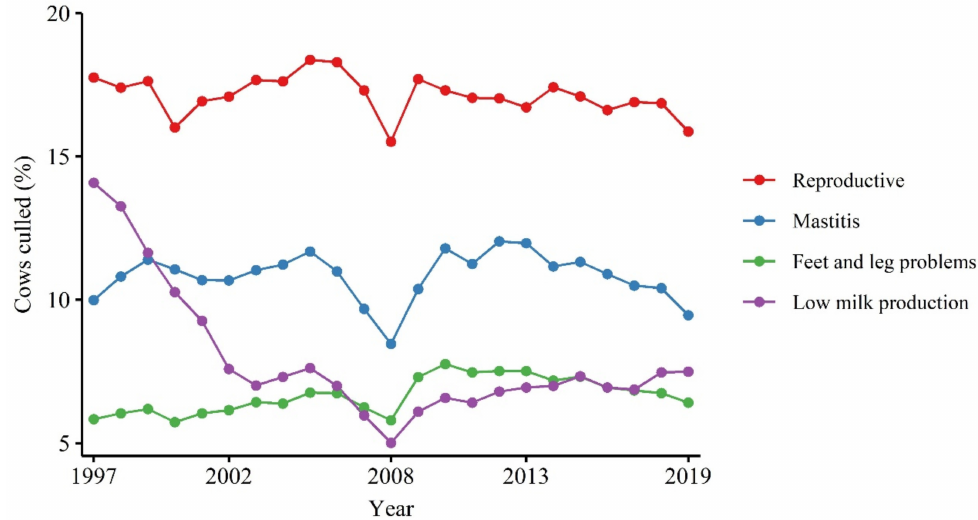
Figure 1. Change over time of the top four culling reasons based on the total number of cows culled with a known reported reason in Canada between 1997 and 2019